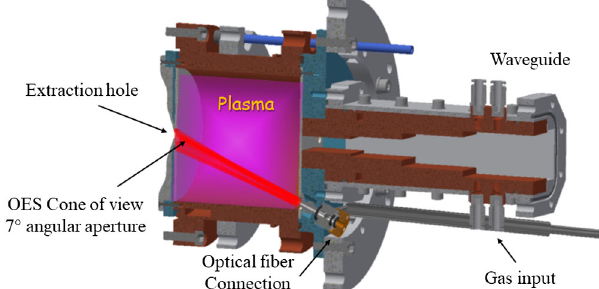
FIG. 3. Sketch of the OES experimental setup including the arrangement of the diagnostics.